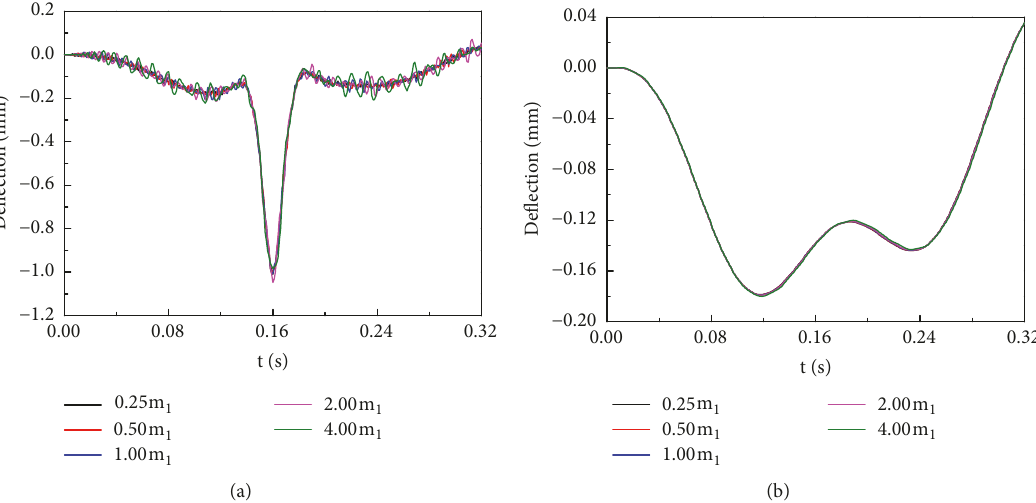
Figure 13: Comparison diagram of mid-span deflection time-history for double simply supported rail-bridge system under different masses of first beam: (a) first beam; (b) second